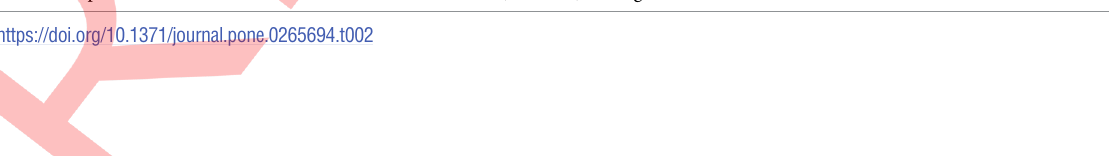
Indole acetic acid at 100 mg L -1 Salicylic acid at 50 mg L -1 Ascorbic acid at 100 mg L -1 Thiourea at 500 mg L -1 LSD (0.05) Different alphabets in the column showed statistical difference ( P � 0.05) among